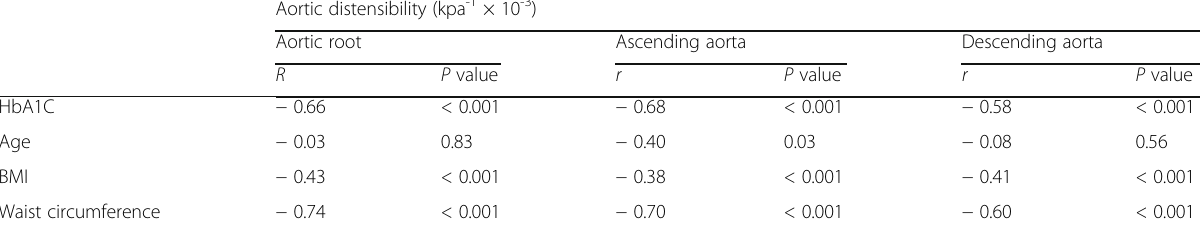
Table 3 Correlation between aortic distensibility, HbA1C, age, BMI, and waist